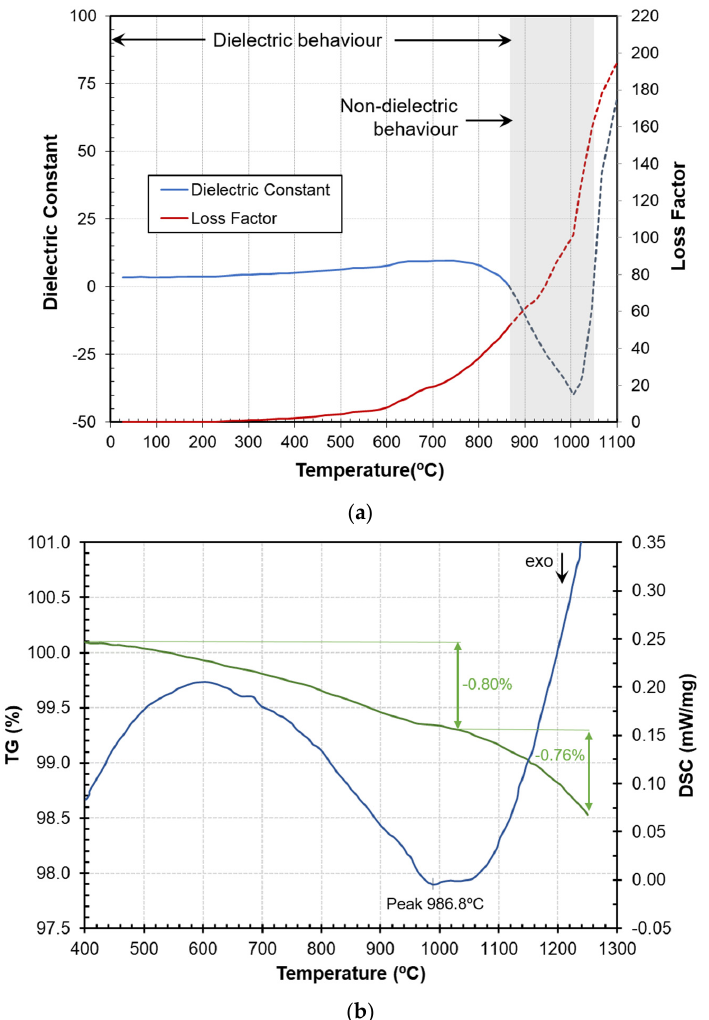
Figure 2. ( a ) Permittivity measurements of the raw materials mixture during the microwave synthesis of the pigment in air; ( b ) DSC-TG analysis of the same process under conventional heating. Continuous heating to higher temperatures resulted in a rapid increase of the absorp- tion of microwaves in the material, which was displayed as a rapid increase in the loss factor but a gradual decrease in the dielectric constant, becoming negative beyond 866 °C. The measured dielectric properties included contributions from both dipoles/ions and conductivity. In some materials, such as metal–insulator compounds, microwave heating can cause the metal particles to form a percolation network, connecting the entire material body and making it conductive. This leads to changes in the electrical properties of the material, and its permi tt ivity becomes negative [28,29]. Despite being located in the region of negative permi tt ivity, the temperature-related variations in dielectric properties exhibited a distinctive peak around 1000 °C. This peak was well correlated with the pigment synthesis, evidenced by the exothermic peak ob- served in the DSC curve (Figure 2b). The DSC curve had a positive slope from this tem- perature because the pigment structure was already formed, and less heat was needed to increase the material temperature. This was also illustrated by the slope change in the